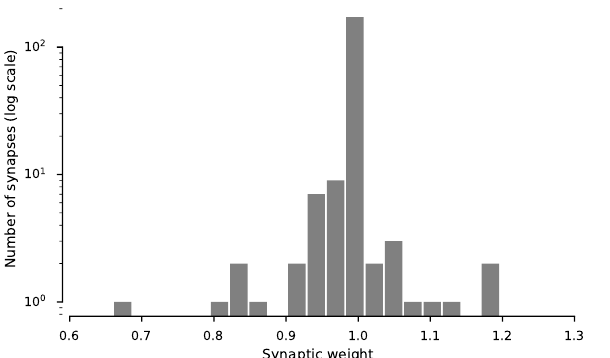
Figure A1. Distribution of synaptic weights after initial trial. Histogram shows the distribution of synaptic weights for all synapses following a single trial (note log scale of y-axis). All weights were initialized at 1, and post-trial weights greater than 1 are potentiation while weights less than 1 are depression.